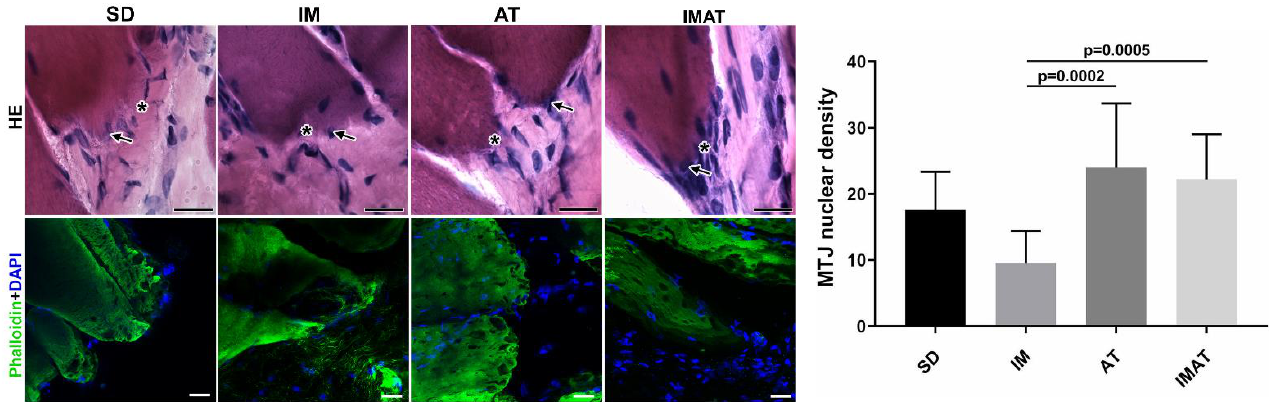
Figure 2. Light microscopy of hematoxylin-eosin staining (HE) of MTJ (*) and adjacent nucleus (arrow) of sedentary (SD), immobilization (IM), aquatic training (AT), and immobilization/aquatic training (IMAT) from gastrocnemius muscle of Wistar rats. Bars: 20 µm. Immunohistochemistry of MTJ region of F-actin (Phalloidin) and nucleus (DAPI). Bars: 20 µm. Mean ± standard deviation of MTJ nuclear density (unity/91.3 mm²) of groups; AT ≠ IM ( p = 0.0002) and IM ≠ IMAT ( p = 0.0005).